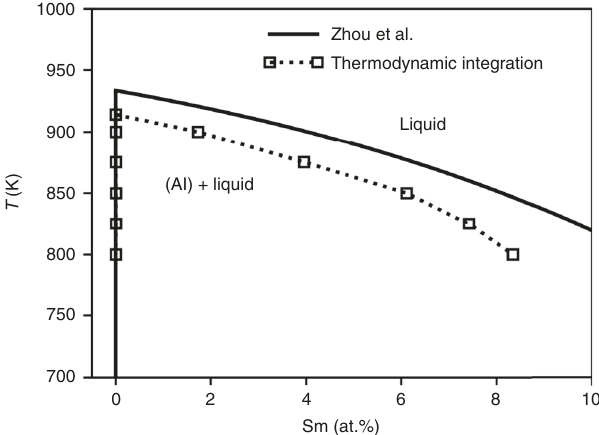
Fig. 2 Al – Sm phase diagram. The phase boundaries between liquid and FCC-Al are calculated from semi-grand canonical MC simulations (squares) using the Mendelev interatomic potential 24 and compared to the CALPHAD assessment of Zhou et al. 27 (solid lines). Note that both assessments report (cid:5) 100 ppm solubility of Sm in